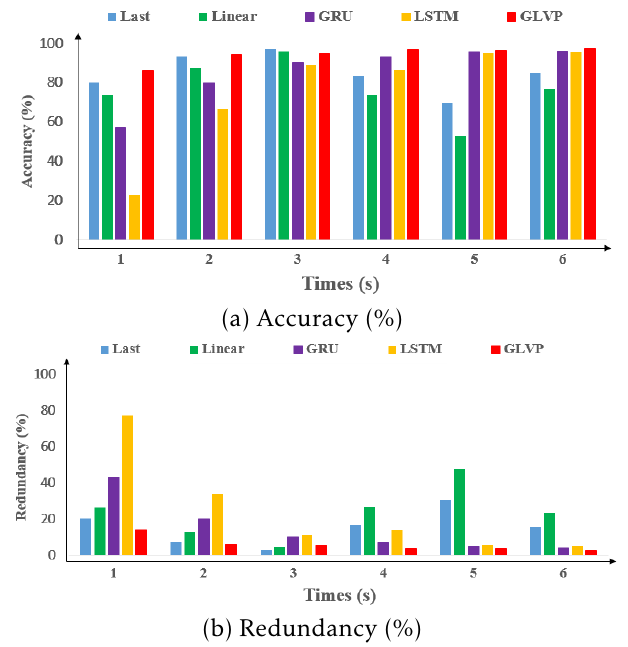
Figure 7. Viewport estimated the performance of the methods reviewed at each early motion trace of Viewport position #1